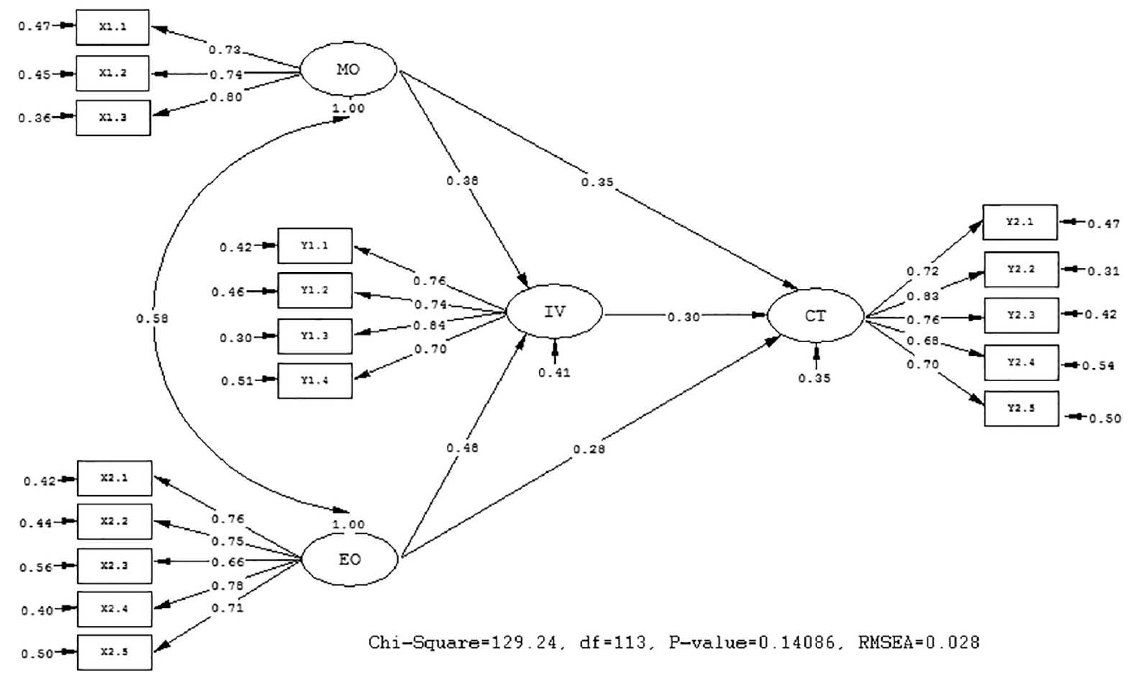
Figure 2. Structural equation modeling of